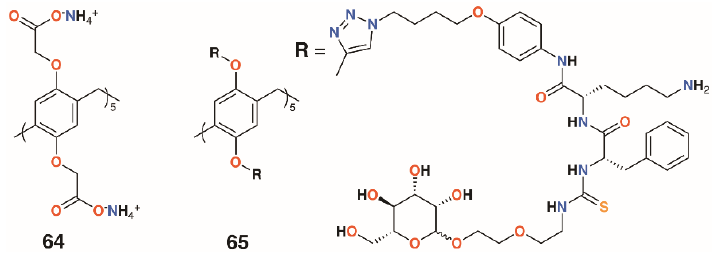
Figure 12. Drug-delivering pillararenes from Notti and He.